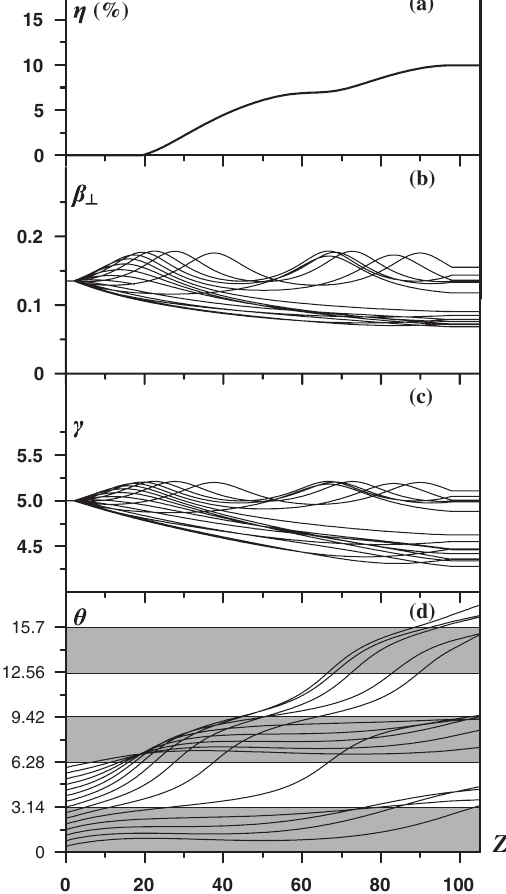
FIG. 13. FEL with a strong conventional guide field driven by an ideal electron beam. Dependence on longitudinal coordinate of (a) electron efficiency as well as (b) transverse velocity, (c) energy, and (d) phase with respect to the rf wave for electrons ¼ 5 : 0 , (cid:4) ¼ 0 : 1 , (cid:4) ¼ 0 : 05 , with different initial phases: (cid:3) w s 0 ¼ (cid:2) 0 : 06 , g ¼ 36 , (cid:4) ¼ 0 : 05 . f ¼ 5 : 6 , (cid:9) 0